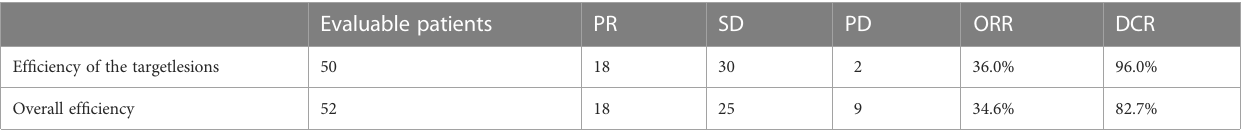
TABLE 2 Overall ef fi ciency and the target lesions evaluation.